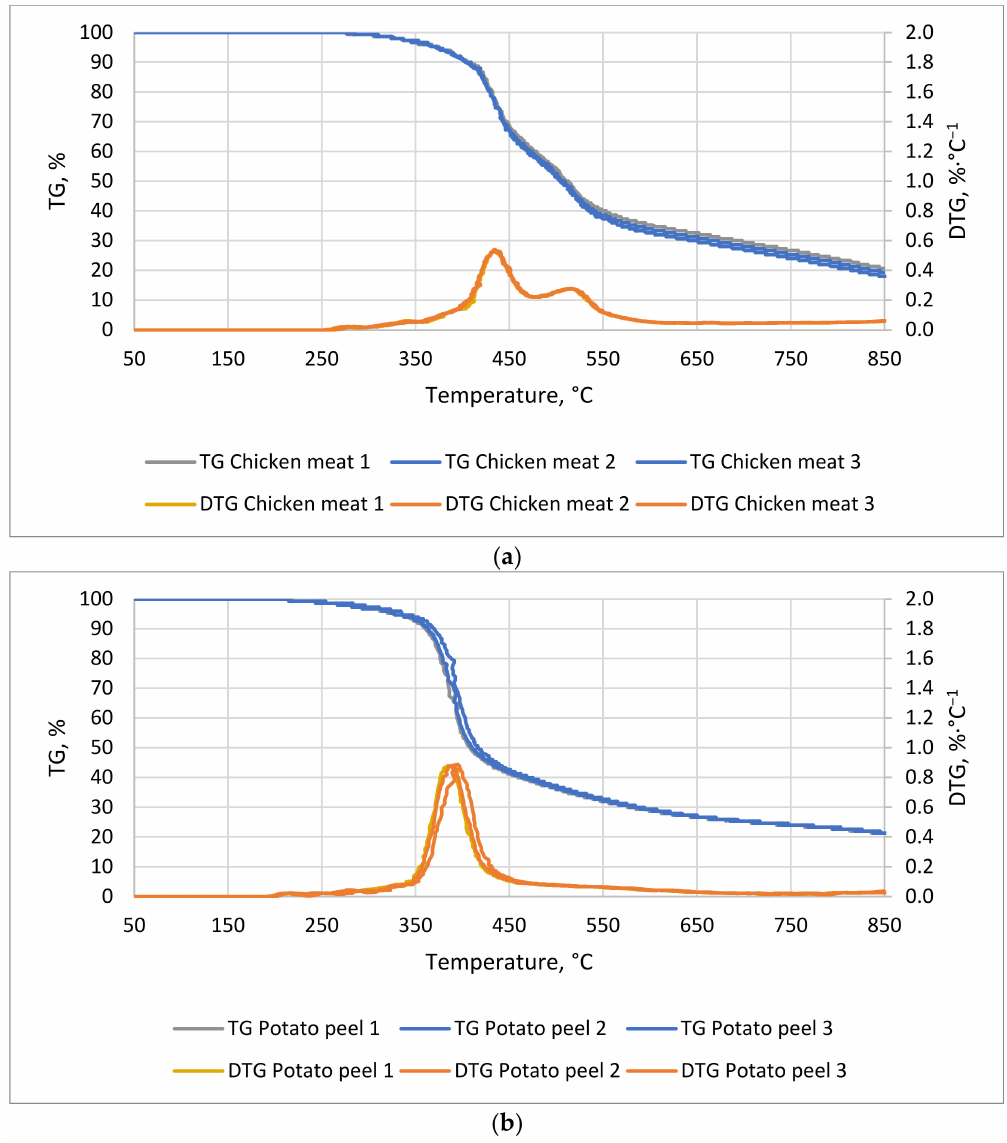
Figure 11. Characteristics of the TG/DTG of biodegradable waste: ( a ) chicken meat; ( b ) potato